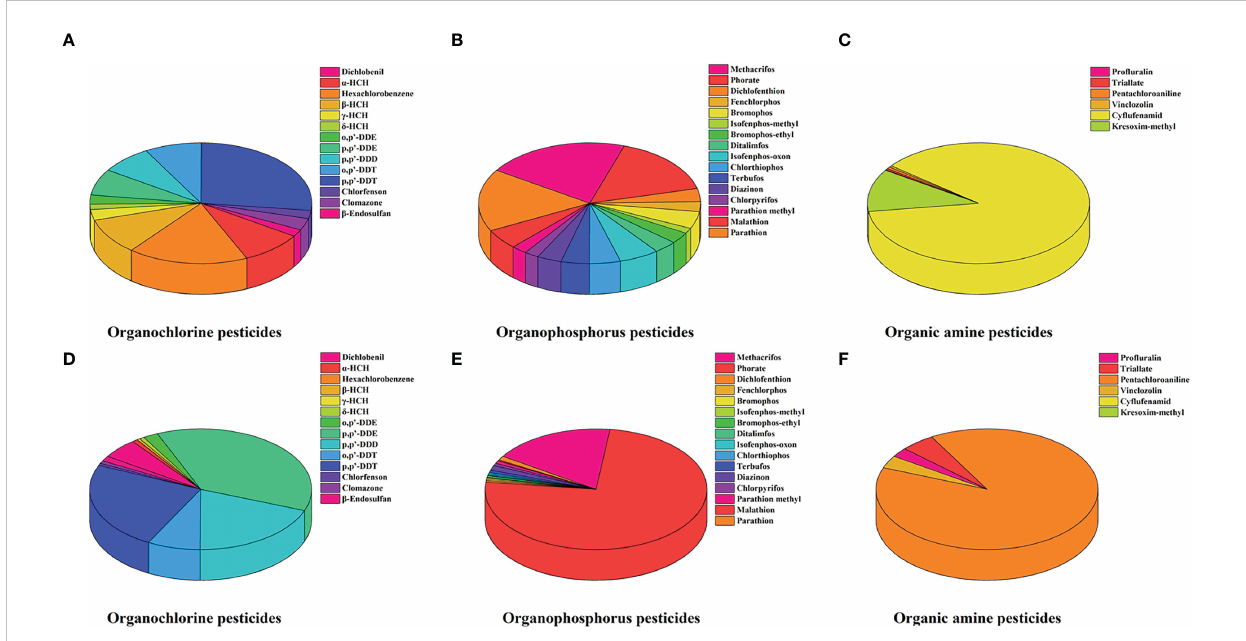
FIGURE 4 Percentage composition of individual pesticides (A-C) in surface seawater, and (D-F) in